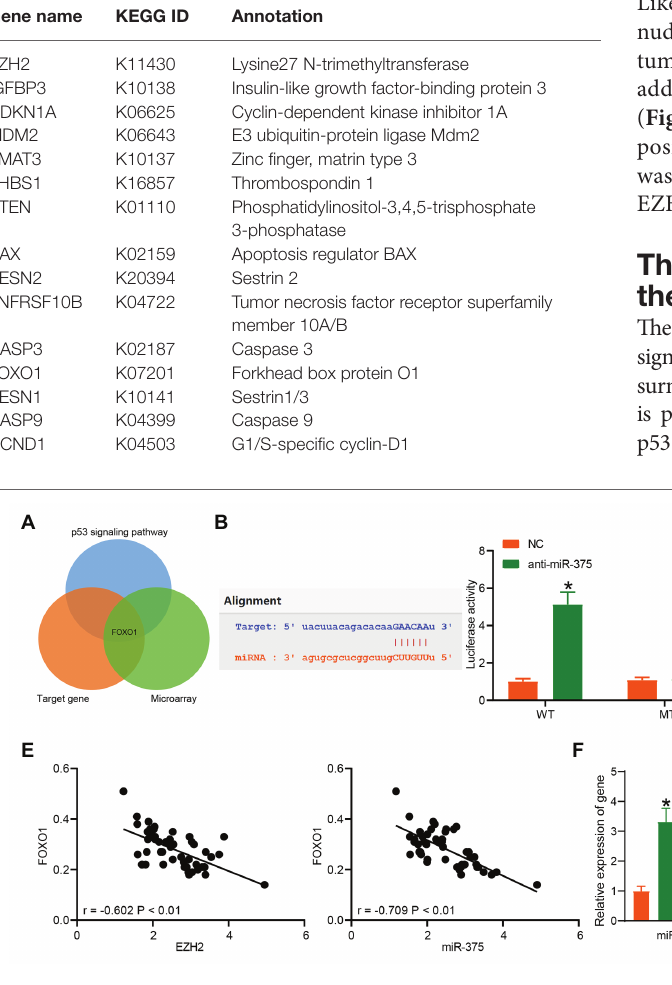
TABLE 3 | KEGG pathway annotations.